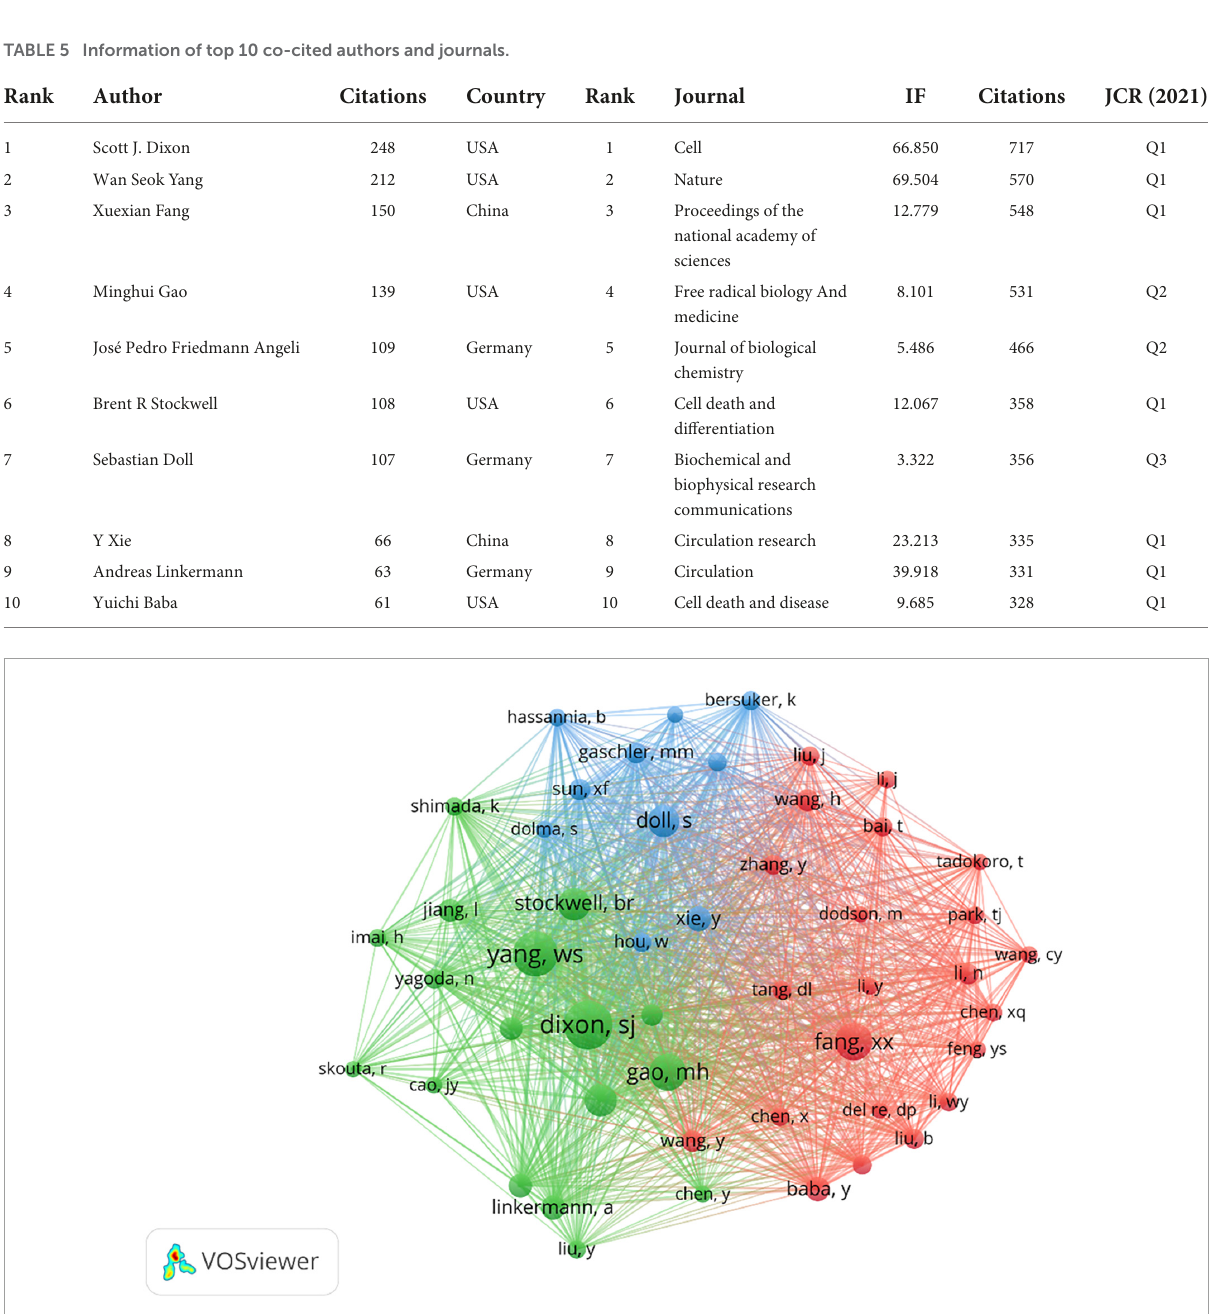
FIGURE5 Distribution of co-cited